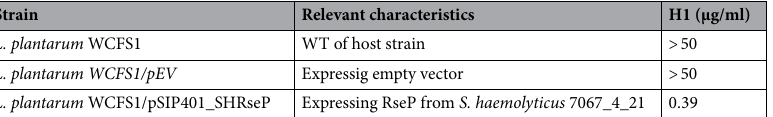
Table 2. Minimal inhibitory concentration (MIC) values (µg/ml) of H1 towards different L. plantarum strains .